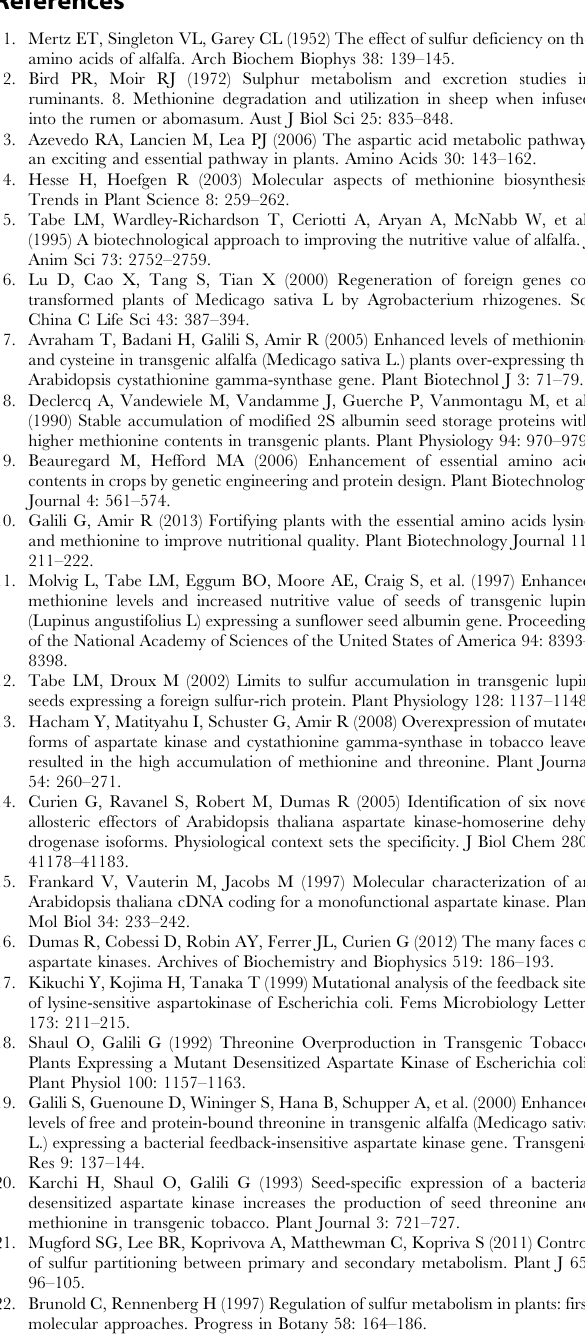
Table S1 Sequence of oligonucelotides used in experiments. fr indicates forward primer and rv indicated reverse primer. Table S2 Contents of total amino acids from the dry weight in wild-type (WT) and transgenic alfalfa overexpressing AK and APR (Line 1-12). Table S3 The height and the weight of the up-ground products of wild-type (WT) and transgenic alfalfa overexpressing AK and APR